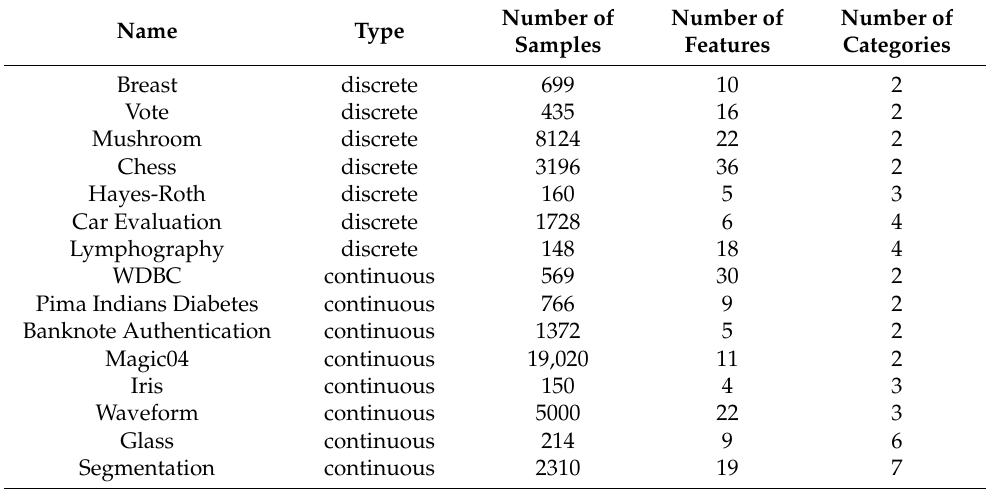
Table 3. Dataset Information.